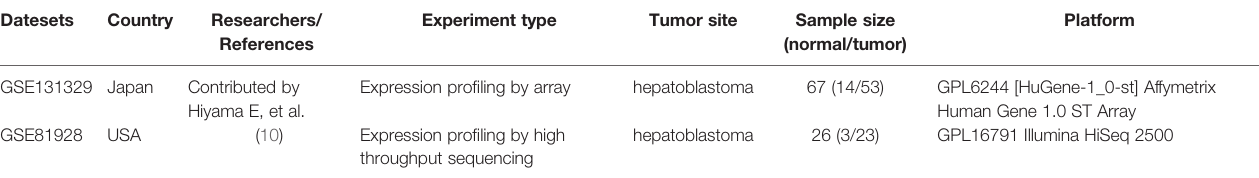
TABLE 1 | The characteristics of the 2 datasets in the study. Datesets